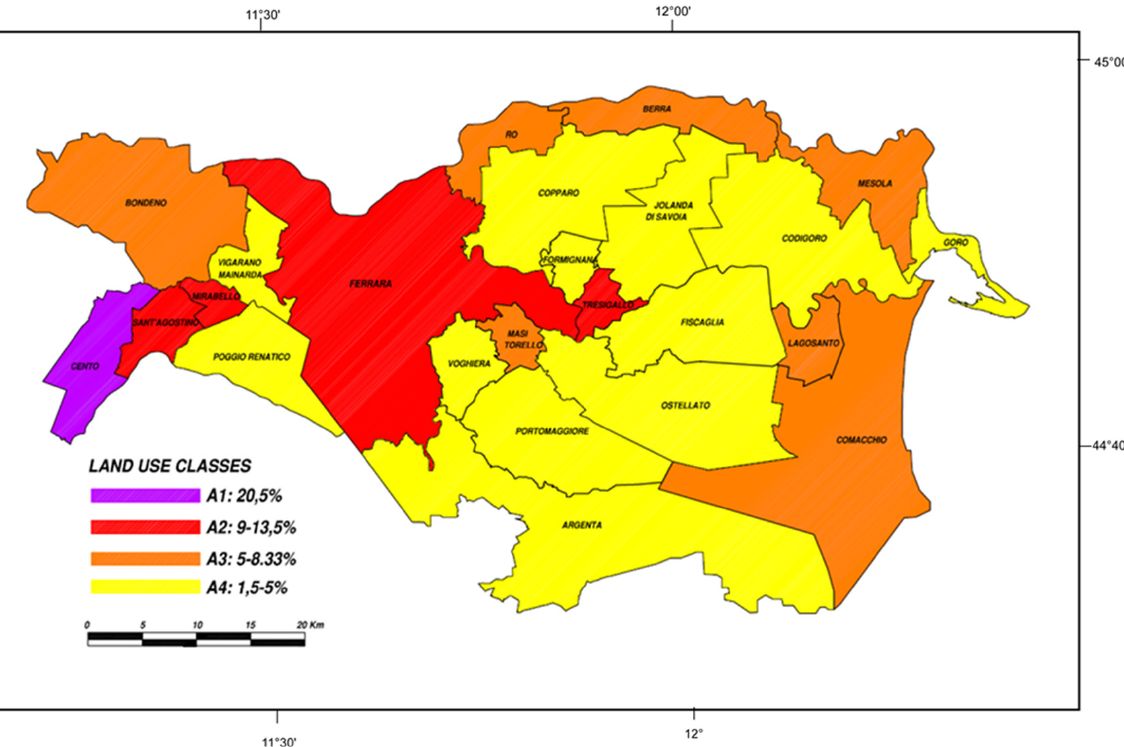
Figure 5. Land use map for the province of Ferrara.